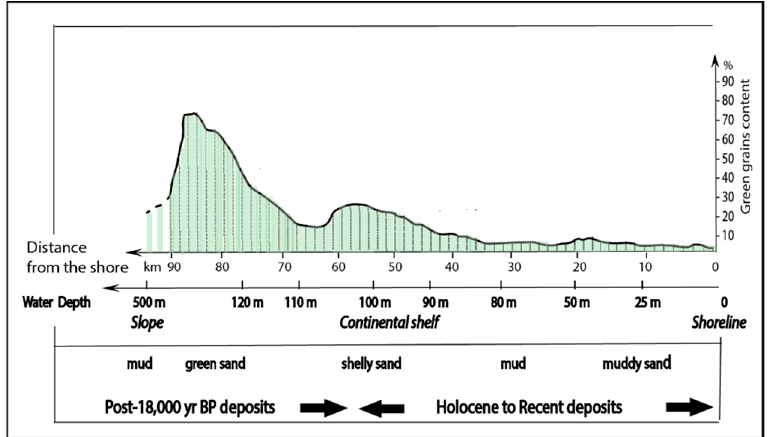
Figure 5. Synthetic section showing, from the coast out to sea, the distribution of sediments. Glauconitic grains are especially abundant on the outer part of the shelf and the top of the slope (redrawn from [26–28] for the chronology and from [29] for the mineralogy.